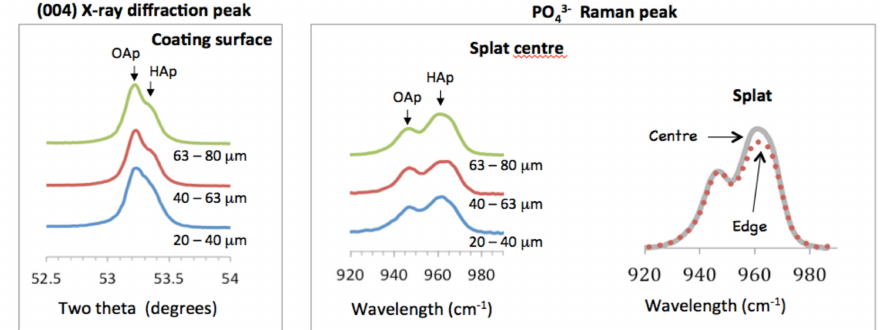
Figure 3. Oxyapatite and hydroxyapatite shown in X-ray di ff raction patterns and Raman spectra. The oxyapatite peak was normalized in both the X-ray di ff raction patterns and Raman spectra for ease of comparison. Raman spectra for the coatings were obtained from the middle of the splat. Raman spectra from the large splat made from 63–80 µ m powder was taken in the center ( ___ ) and edge ( ... ) of the